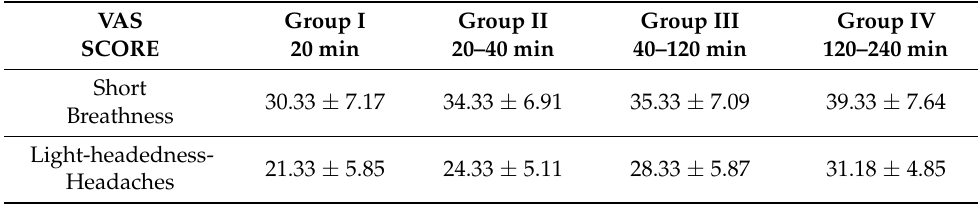
Table 2. Summary of the surgeons visual analogic score (VAS) of shortness of breath and light- headedness and headaches of Group I (20 min), II (20–40 min), III (40–120 min) and IV (120–240 min) (ANOVA post hoc Tukey